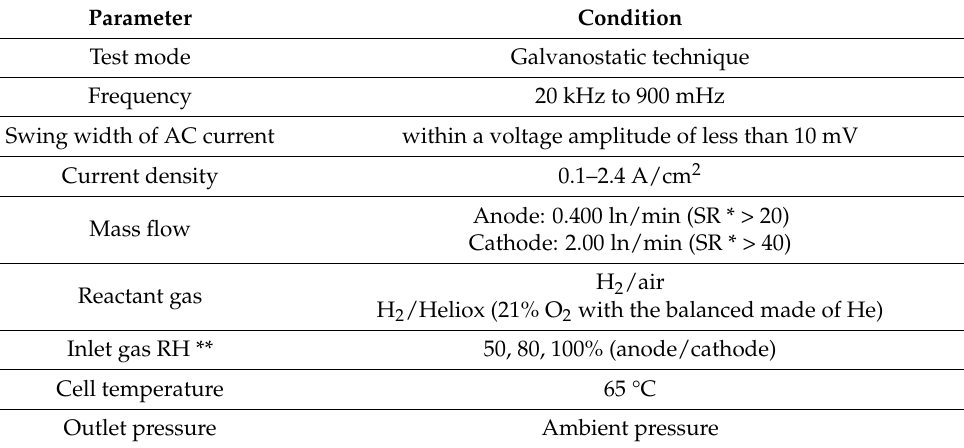
Table 1. Operating conditions for measuring the EIS and polarization curve.